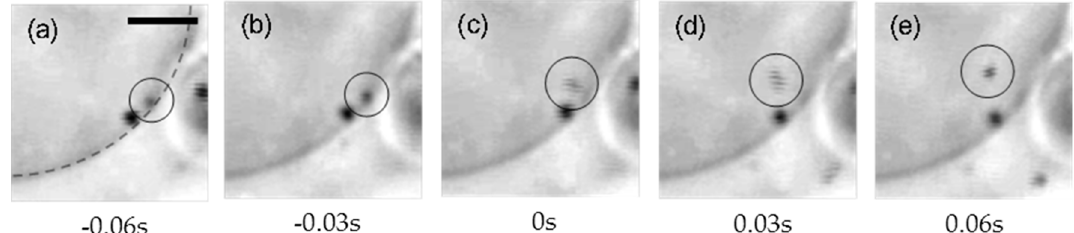
Figure 3. ( a – e ) Time-lapse images of the particle-uptake into a liposome (the time 0 s means the initiation of the particle penetration.). The black circle surrounds a 200 nm fully wrapped particle. The gray broken line shows the edge of the liposome. Scale bar is 10 µm.